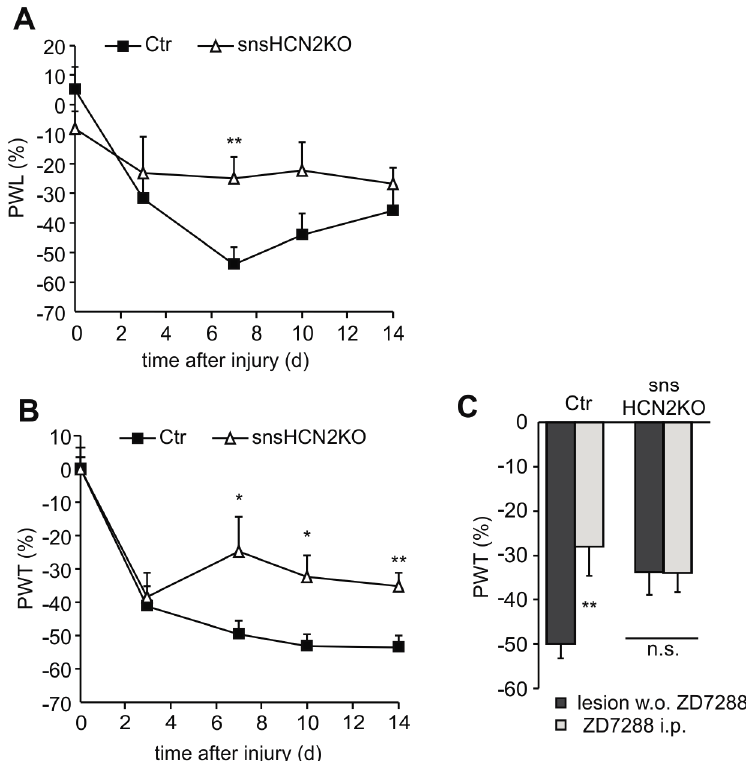
Figure 2. Mice with a selective deletion of HCN2 in peripheral sensory neurons (snsHCN2KO) display reduced neuropathic pain behavior in response to ( A ) noxious heat and ( B ) mechanical stimulation ( n = 9–10 mice); ( C ) Block of HCN channels by intraperitoneal (i.p.) injection of ZD7288 (4 mg/kg) 14 days after nerve injury significantly decreased mechanical hypersensitivity in controls (Ctr), but had no effect in snsHCN2KO ( n = 5 mice). All data are presented as relative difference between the injured right and the non-injured left hindpaw ((R − L)/L × 100). PWT and PWL, paw withdrawal threshold and paw withdrawal latency, respectively. * p < 0.05, ** p < 0.01. n.s., non